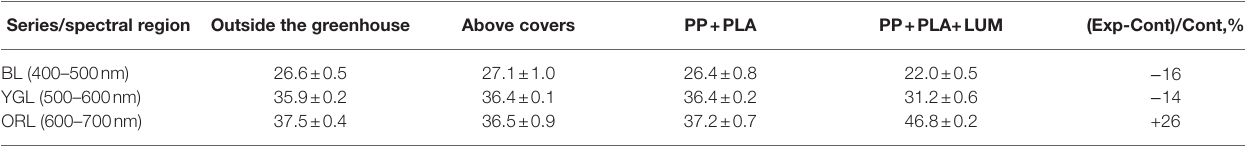
TABLE 1 | Percent contribution of light of different spectral regions: blue (BL), orange–red (ORL), and yellow–green (YGL) inside (above and below the coverings) and outside of the greenhouse during the cultivation period. Series/spectral region Outside the greenhouse Above